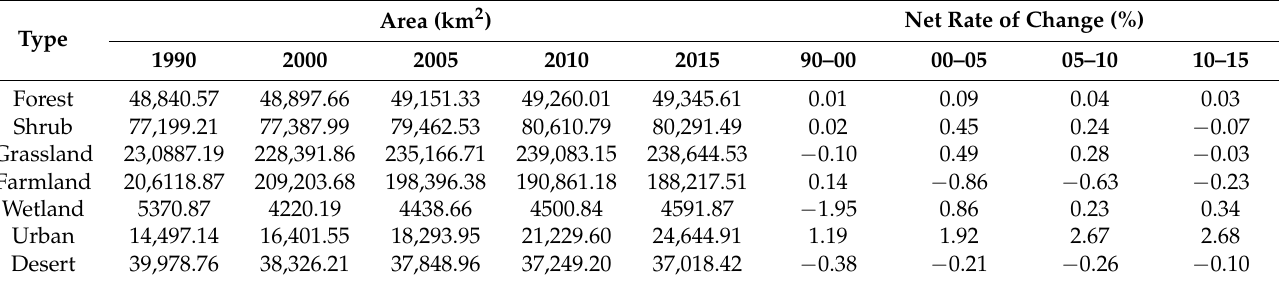
Table 3. Changes in ecosystem areas in different periods on the Loess